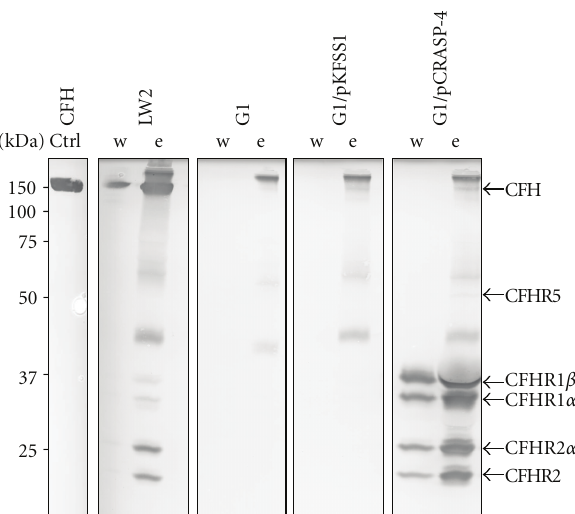
Figure 4: Binding of serum molecules by B. garinii transformants. B. garinii strains G1, G1/pKFSS1, and G1/pCRASP-4 and B. burgdorferi strain LW2 (used as control) were incubated in NHS plus EDTA to prevent complement activation and washed extensively, and bound proteins were eluted using 0.1 M glycine (pH 2.0). Both the last wash (w) and the eluate (e) fractions obtained from each strain were separated by SDS-PAGE and transferred to nitrocellulose. As an additional control purified CFH (1 μ g) was also applied. Membranes were probed with a polyclonal anti-FHR1 antiserum which recognizes CFH, CFHR1, CFHR2, and CFHR5. Mobilities of molecular mass standards are shown to the left of the panels.